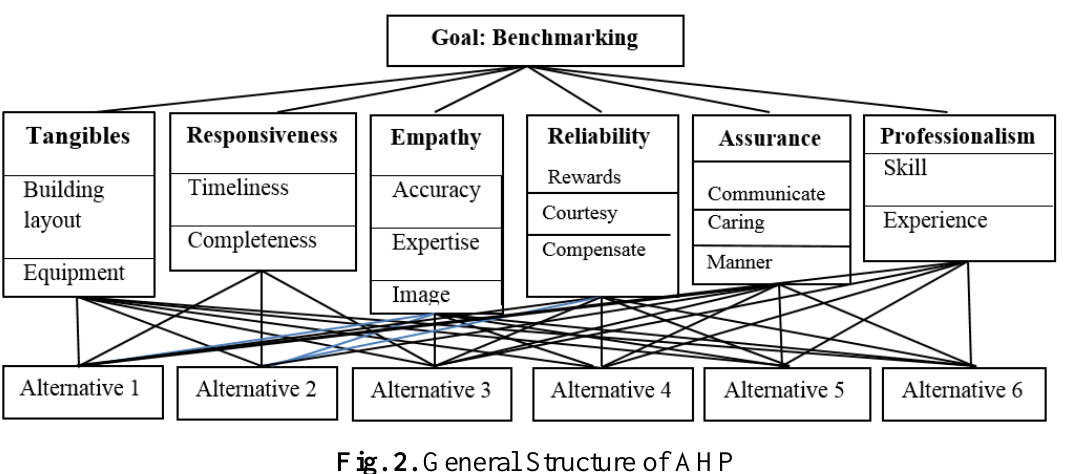
Fig. 2. General Structure of